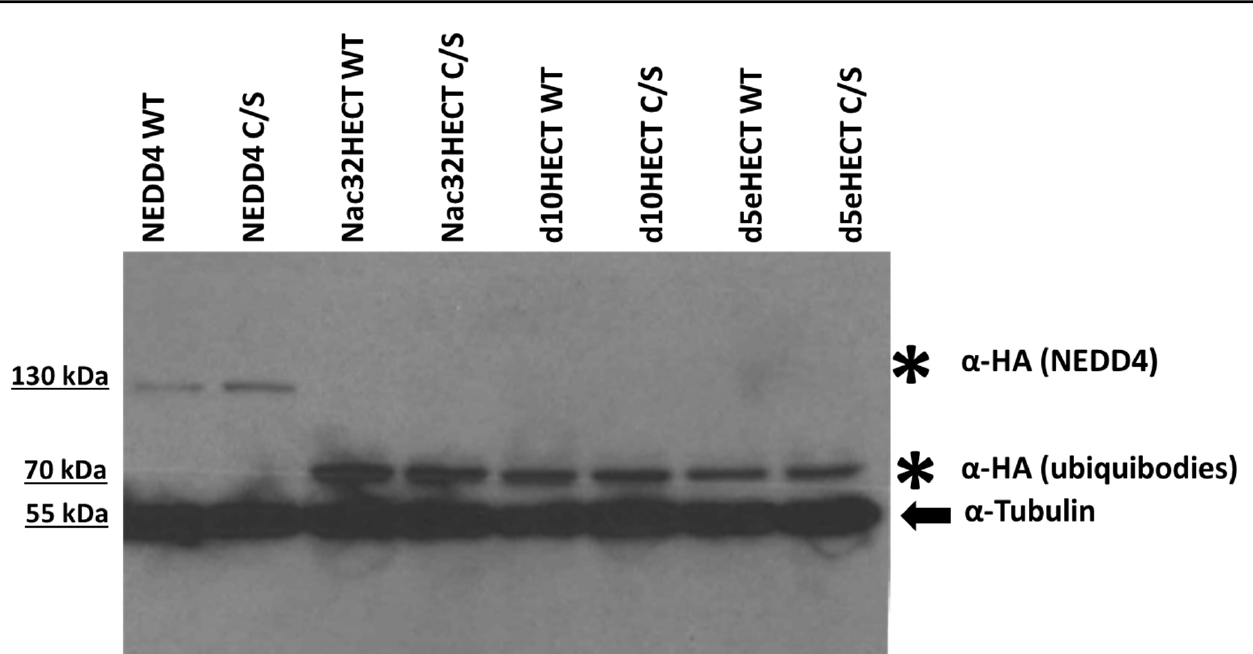
Figure 3. RLPs lead to the expression of the different ubiquibodies in 293T cells. Cells were transduced with RLPs, expressing the following constructs, as indicated: NEDD4 WT; NEDD4 C/S; Nac32HECT WT; Nac32HECT C/S; d10HECT WT; d10HECT C/S; d5eHECT WT; d5eHECT C/S. Forty-eight hours post-transduction, cells were harvested and proteins were run on an SDS-PAGE gel, followed by western blot with an HA antibody, recognizing NEDD4 (~120 kDa bands) as well as the different ubiquibodies (~70 kDa bands), along with an anti-tubulin antibody (~55 kDa bands) as loading control.